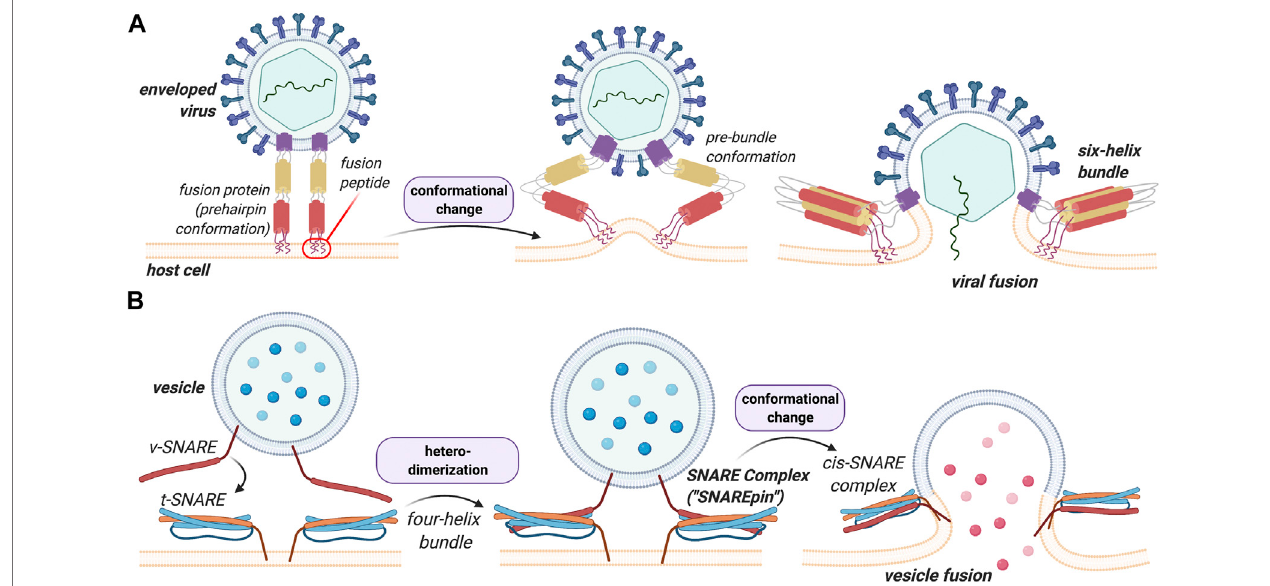
FIGURE 1 | Structural and functional comparison between viral HA and eukaryotic SNARE in membrane fusion events. A key differencebetween these processes isthatheterodimerizationoftheSNAREsisaprerequisiteforthevesicularprocesswhereasviralfusionproteinsinsertanddestabilizethelipidbilayerstoinducefusionina more general manner. (A) Viral fusion events are mediated by the binding of fusion proteins to the membrane of the host cell. The proteins undergo a conformational changethatallowsthemembranestomerge. (B) v -SNAREonthevesicleandthe t -SNAREonthetargetmembranebindtooneanotherleadingtotheformationof the trans -SNARE complex. A more detailed description of this process and its structural features can be found